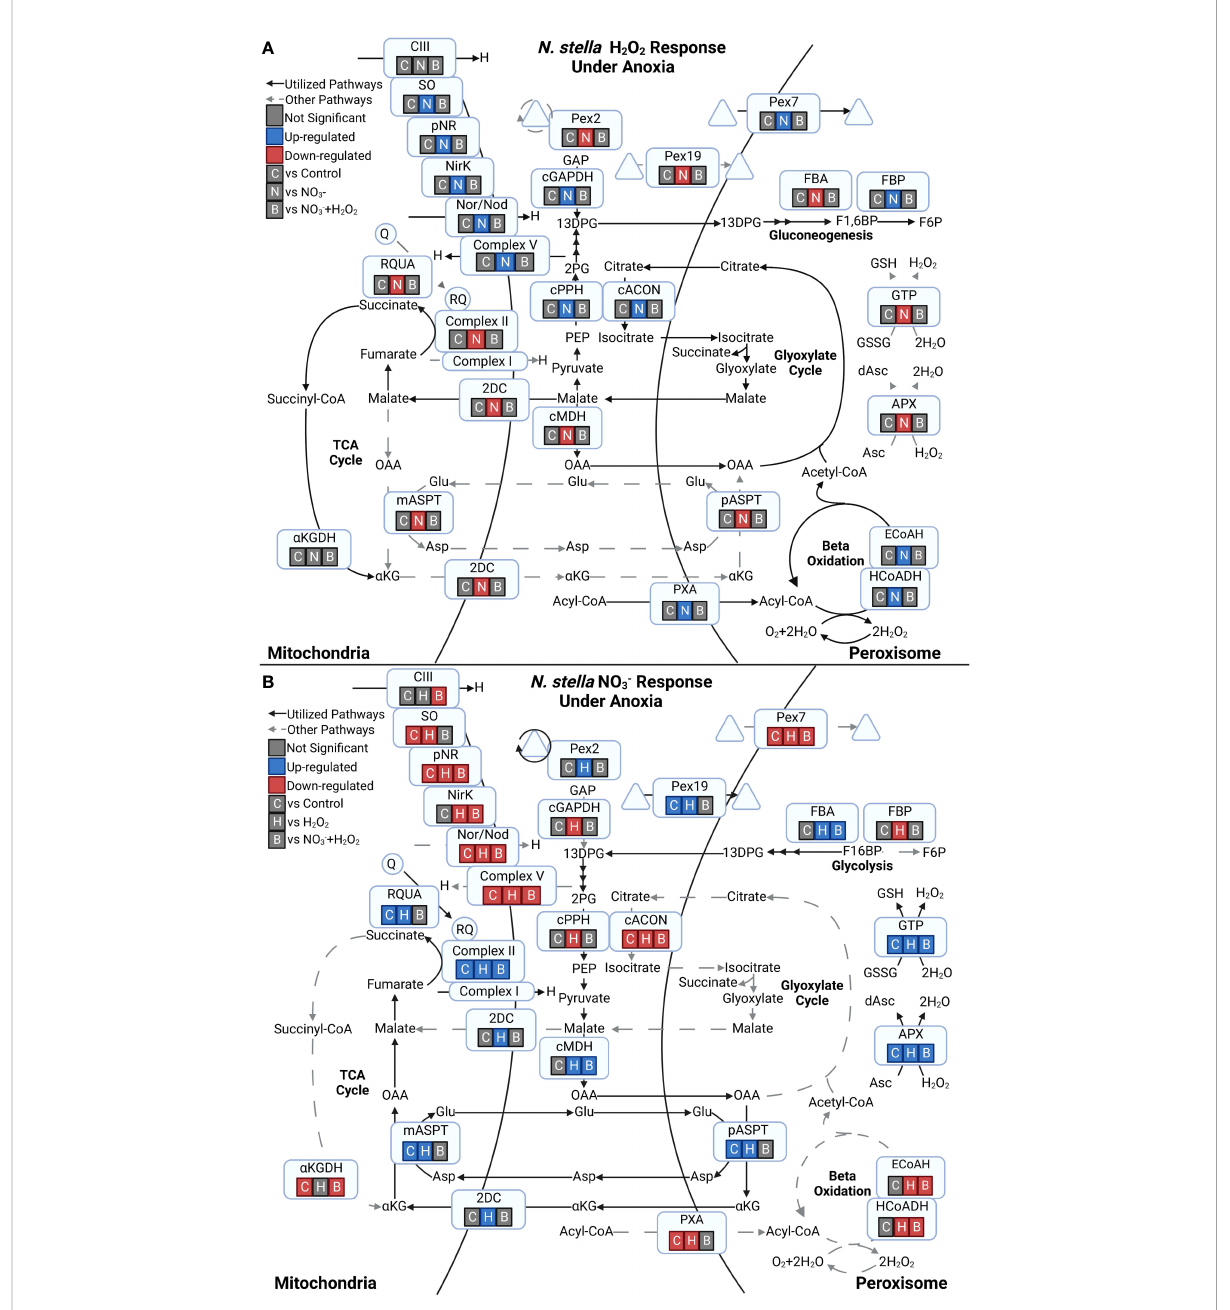
FIGURE 5 Responses to chemical amendments under anoxia for proteins predicted to the peroxisome and mitochondria in N. stella . (A) Differential expression of genes under the H 2 O 2 amendment in contrast to the control (C), NO − 3 (N), and combined H 2 O 2 + NO − 3 (B) amendments. (B) Differential expression of genes under the NO − 3 amendment in contrast to the control (C), H 2 O 2 (H), and combined H 2 O 2 + NO − 3 (B) amendments. Triangles in both panels represent transported and recycled proteins. Signi fi cant differential gene expressions between contrasts (adjusted p-value< 0.05) are highlighted in green (Up-regulated) or red (Down-regulated). Contrasting conditions with no signi fi cant differential gene expression are indicated in gray (Not Signi fi